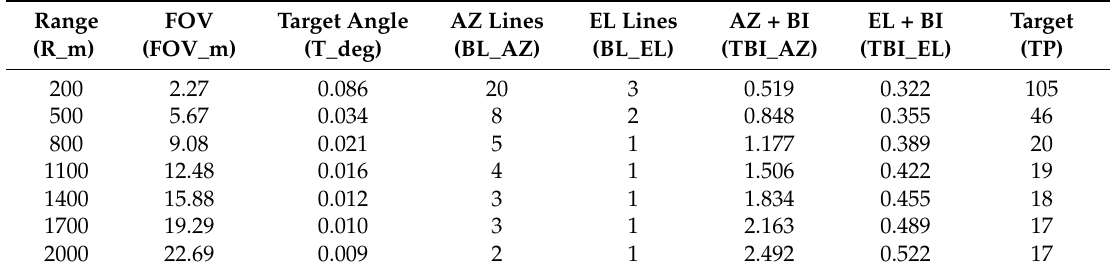
Table 1. Calculation for target projection points in different